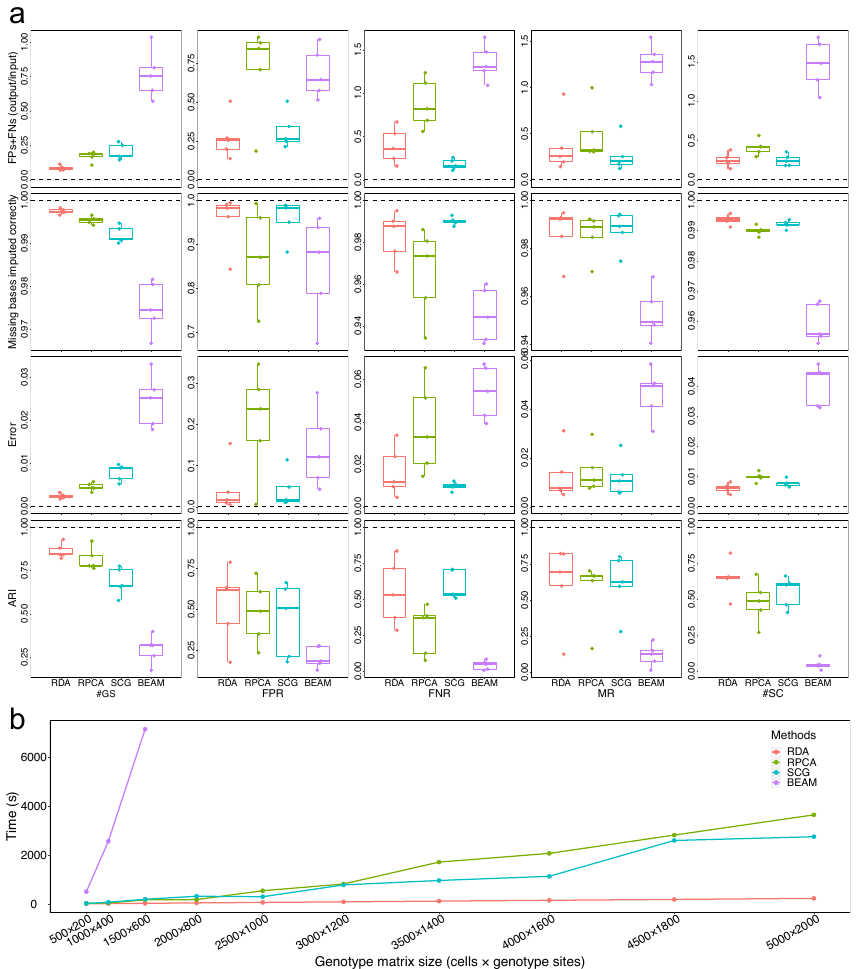
Figure 2. Genotype matrix recovery accuracy, clustering, and run-time comparison on the simulated datasets. ( a ) The matrix recovery accuracy (evaluated by FPs + FNs, missing bases imputed correctly, error), and clustering accuracy (evaluated by ARI between the known clustering and the predicted clustering based on recovered matrix) for each method. ( b ) Run-time comparison for fitting four models on the ten simulated datasets with different sizes of cells, genotypes and subclones. Clearly, the computational complexity of RDAClone is almost linear against the matrix size, which is much efficient comparing with other